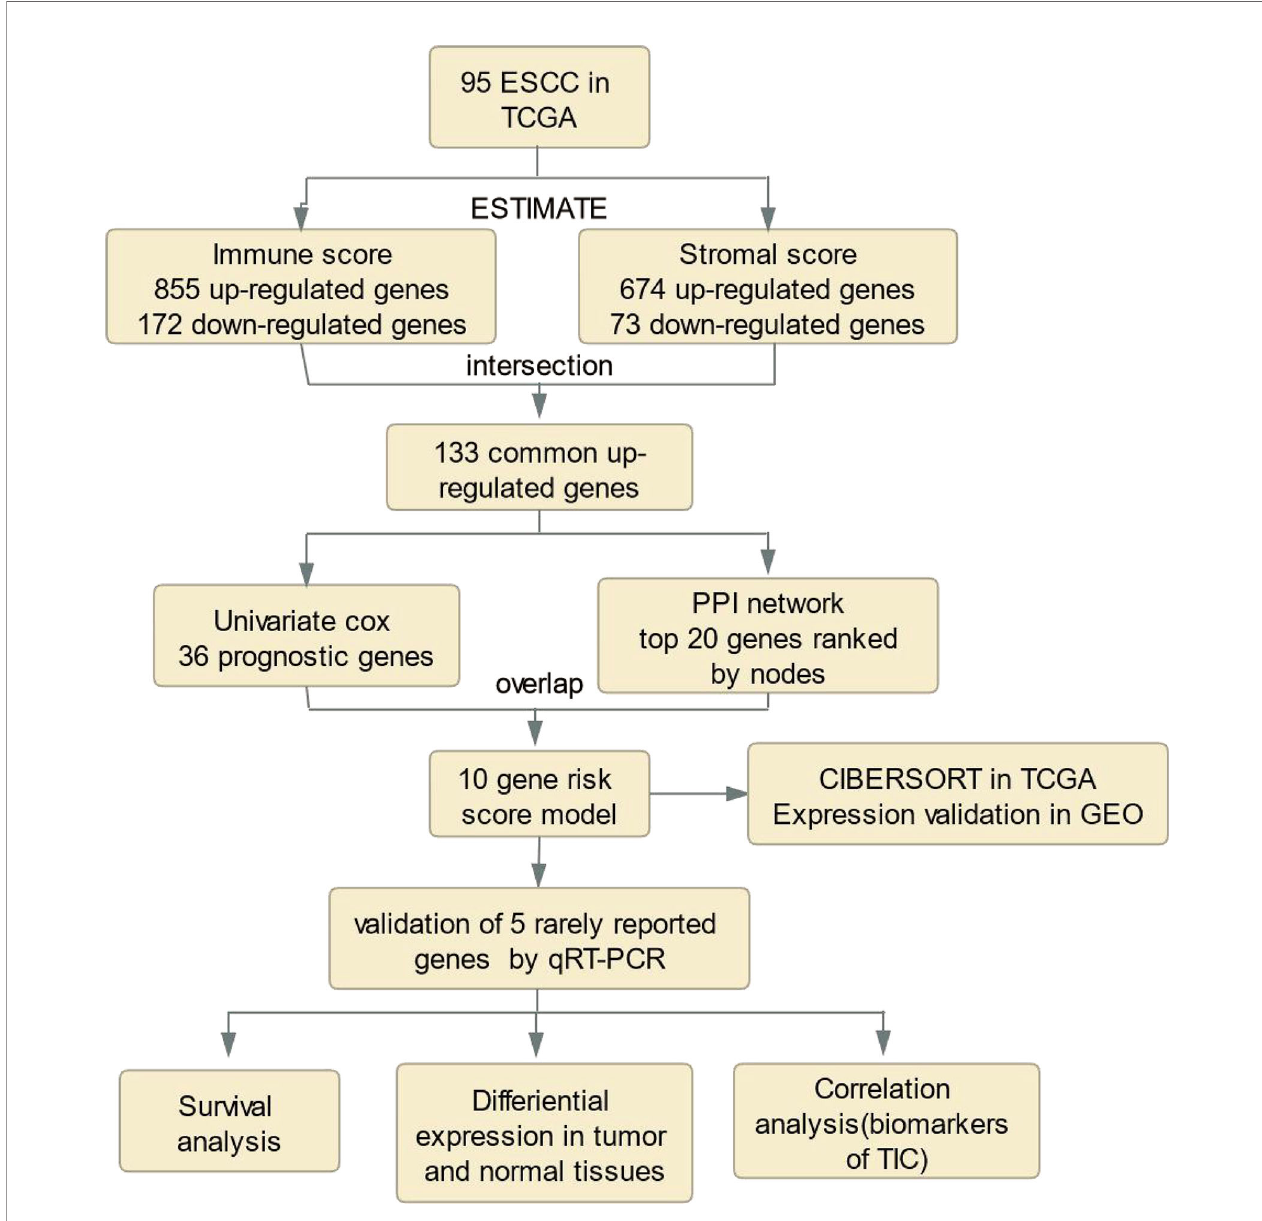
FIGURE 1 | Analysis work fl ow of this